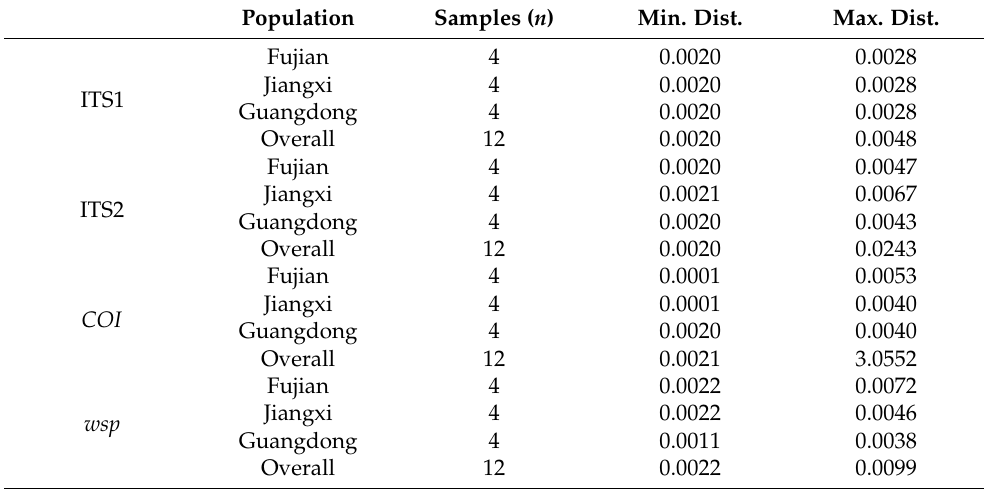
Figure 1. Phylogenetic analysis based upon ITS1 region of thirteen different sequences of Tamarixia radiata populations from different geographical locations. ( A ) Tree was constructed using the Maximum Likelihood (ML) method through the General Time-Reversible model under the maximum parsimony, while ( B ) tree was constructed through the Neighbor-Joining method Maximum Composite Likelihood model. All Tamarixia radiata sequences obtained in the study are highlighted in green lines and font. Table 3. Distance divergence (%) within the provinces and overall populations of Tamarixia radiata.